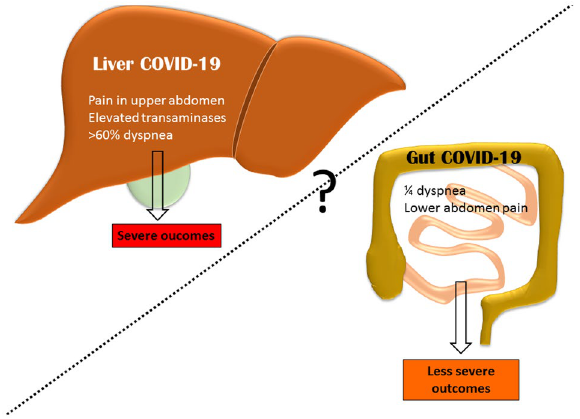
Figure 3. Proposed hypothesis of two forms of COVID-19 gastrointestinal symptoms: the liver and the gut COVID-19. Liver COVID-19 could be associated with upper abdomen pain and, dyspnea and more severe clinical outcomes while gut COVID-19 with lower abdomen pain and less severe